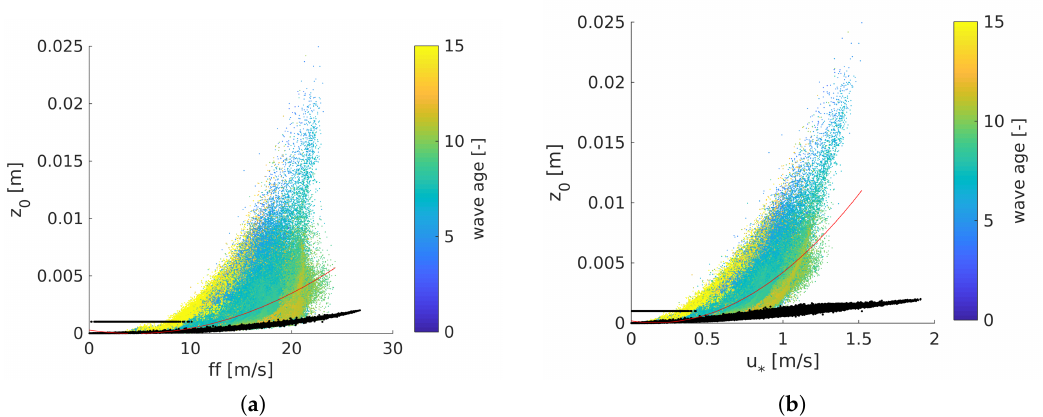
Figure 3. Scatter plots of the ( a ) wind speed (ff) and ( b ) friction velocity ( u ∗ ) against the roughness length ( z 0 ) for the reference model simulation (black dots) and the coupled model simulation (coloured dots). The red lines indicate the least-squares best-fit lines of the roughness lengths calculated by WAM. Values of 0.001 represent the roughness length of sea